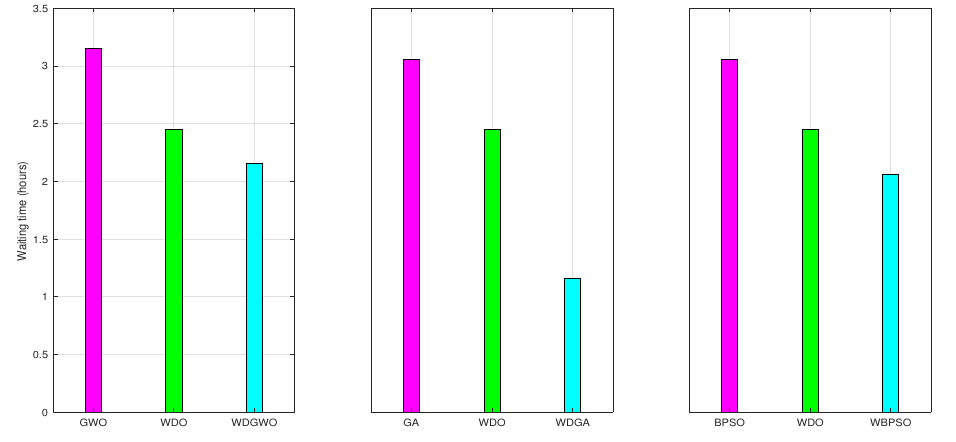
Figure 12. Appliances waiting time by WDGA, WDGWO and WBPSO.